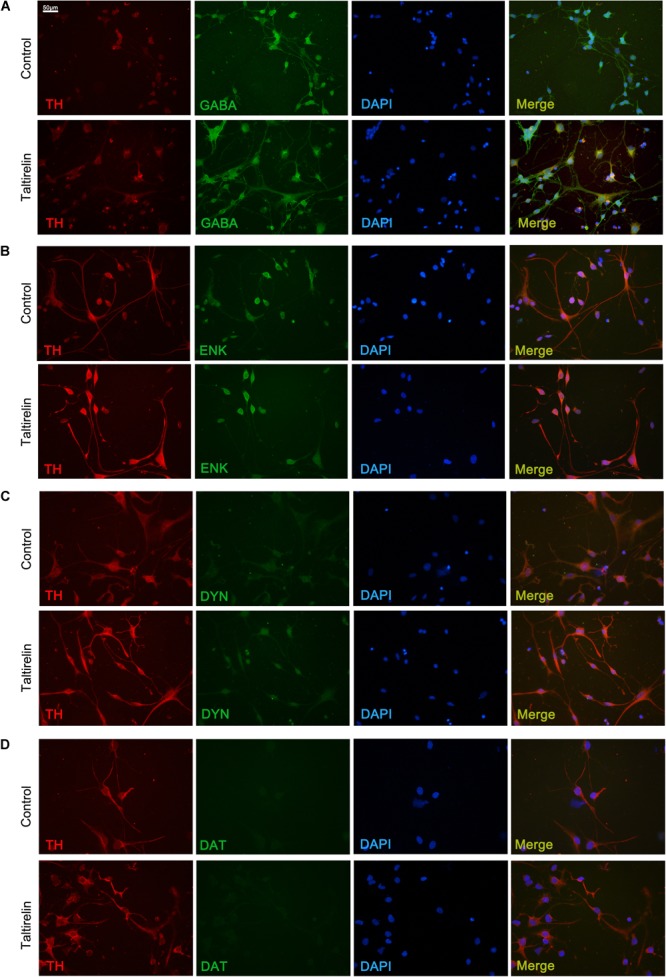
Taltirelin elevated the level of TH in enkephalin-positive neurons in vitro. Double immunolabeling images showed co-localization of tyrosine hydroxylase (TH) with GABA (A), enkephalin (B), dynorphin (C) or dopamine transporter (DAT) (D) in control or Taltirelin treated rat primary striatal neurons. N = 3.